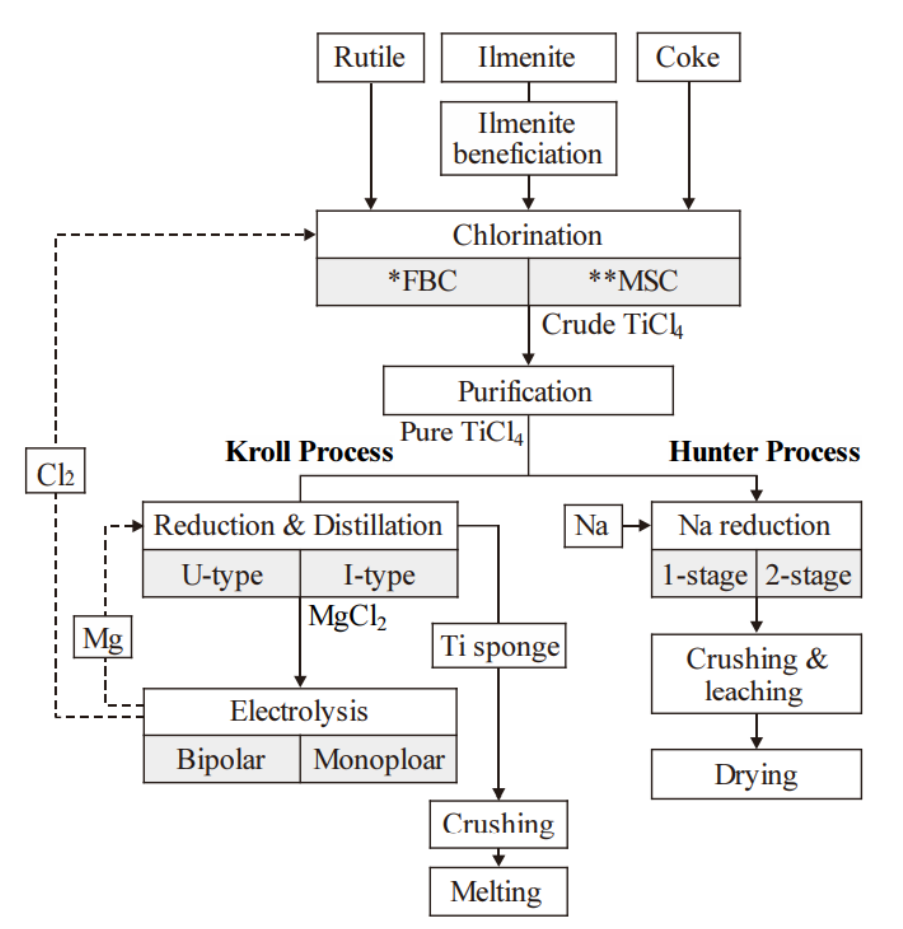
Figure 2. Flowchart of the Hunter process and the Kroll process [32] (Adapted from [32], with permission from The Korean Institute of Resources Recycling, 2020).